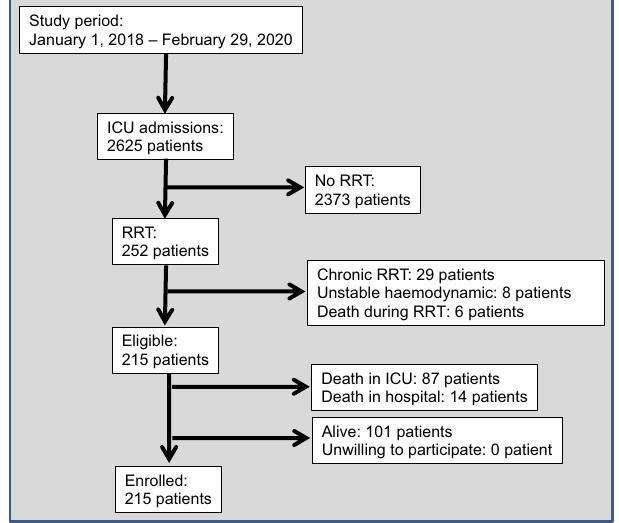
Figure 1. Patients flow chart.